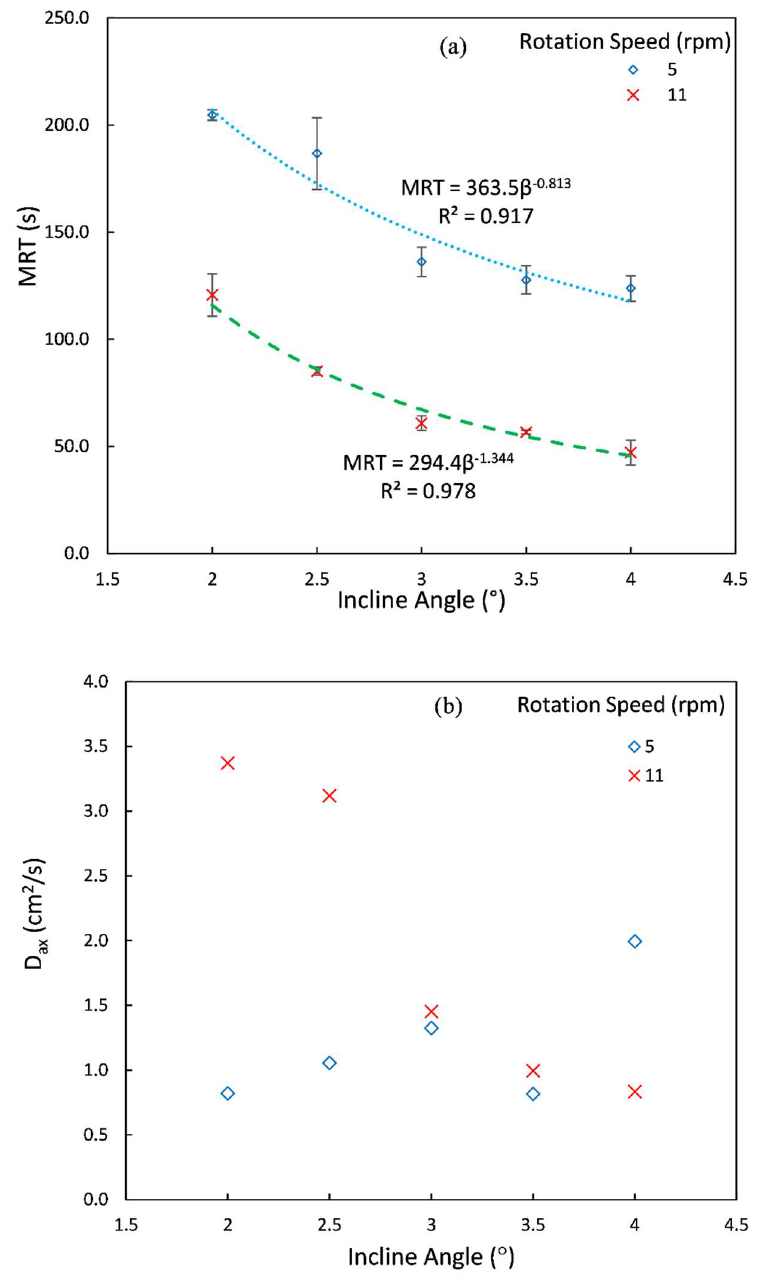
Figure 7 . Effect of incline angle on ( a ) MRT ( b ) axial dispersion coefficient at 1.08 cm 3 /s for a 6 mm cube.